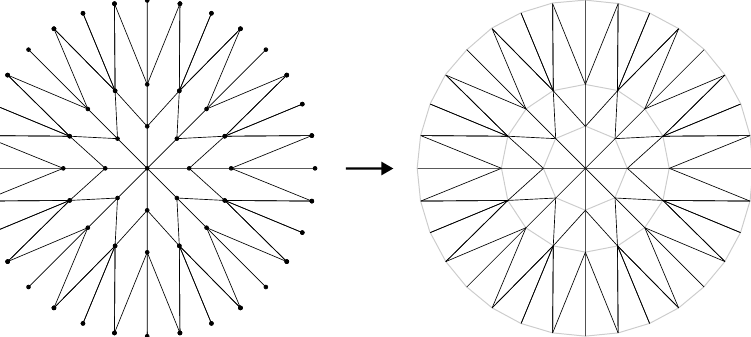
Figure 4. Lattice triangulation. The geometric representation of the graph is triangulated (using Delaunay triangulation, for example) to tessellate the sensor space and facilitate collision detection. The edges of the lattice are shown in black and the edges completing the triangles are shown in